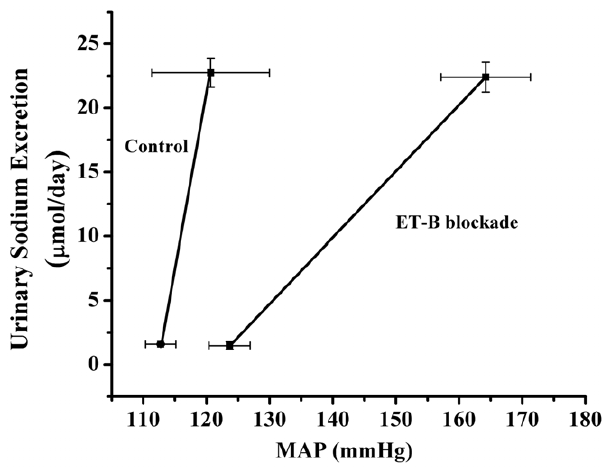
Figure 2. Pressure natriuresis relationship in response to intramedullary ET-B blockade. In response to chronic intramedul- lary ET-B blockade, there is a rightward shift of the pressure natriuresis relationship suggesting there is an impairment of the kidneys’ normal ability to excrete salt and water.